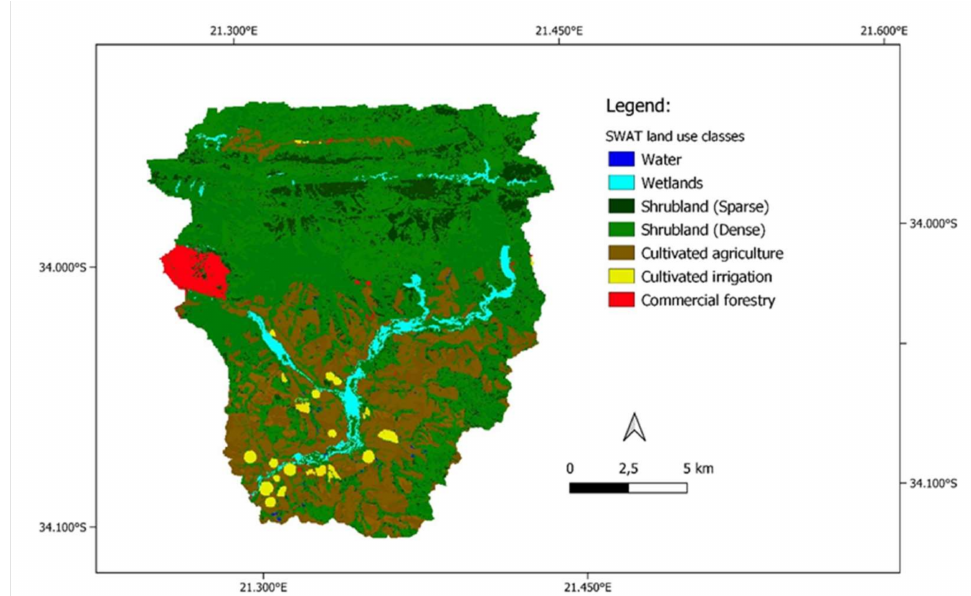
Figure 2. Land uses of the study